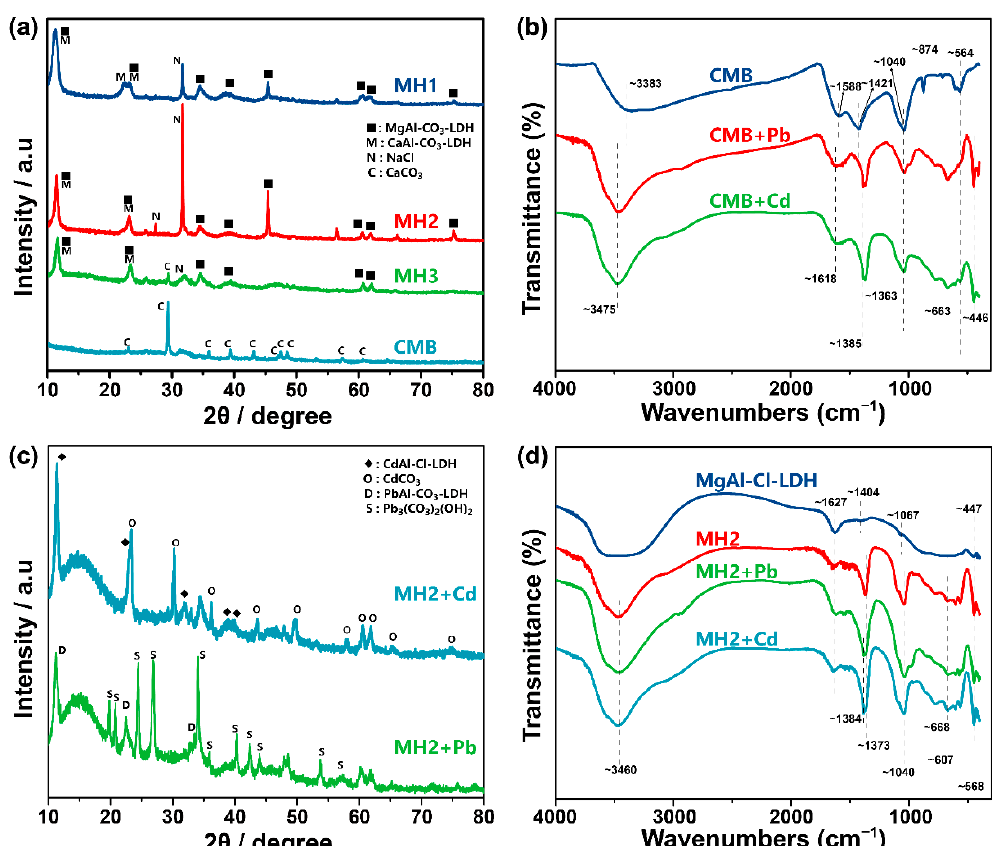
Figure 1. ( a ) XRD patterns of CMB, MH1, MH2 and MH3. ( b ) FTIR spectra of CMB before and after adsorption of Pb and Cd. ( c ) XRD patterns of MH2 after adsorption of Pb and Cd. ( d ) FTIR spectra of MgAl-Cl-LDH and MH2 before and after adsorption of Pb and Cd. XRD: X-ray diffraction. FTIR: Fourier Transform Infrared Spectroscopy. CMB: chicken-manure biochar. MH1, MH2, MH3 are the obtained MgAl-Cl-LDH-doped CMB prepared with 5 g, 15 g or 30 g CMB and 0.15 mol MgCl 2 and 0.075 mol AlCl 3 .